Question: Describe this figure in one sentence.
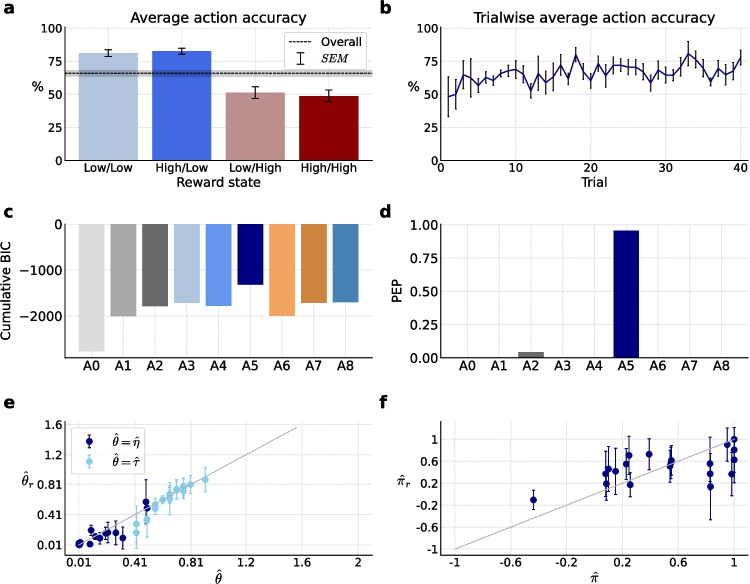
Answer: Post-hoc model validation analyses results. The panels depict post-hoc model validation analyses results of 50 data sets generated based on the most plausible behavioral model and the corresponding ML parameter estimates for each participant. The data analysis procedure was repeated 10 times. a Average action accuracy by reward state. The dashed line represents the overall average action accuracy across all reward states and the 10 data analysis repeats. The light gray area around this dashed line refers to the average SEM . The colored bars represent the reward state-specific average action accuracies. The error bars depict the SEM . b Trialwise average action accuracy across all reward states and the 10 data analysis repeats. Error bars refer to the SD across the 10 data analysis repeats. c Group-cumulative BIC values for all behavioral models in our model space. Behavioral models are differentiated by their bar colors. Higher BIC values refer to higher model plausibility (cf. Schwarz, 1978 ) d PEPs for all behavioral models in our model space. e Parameter recovery results for agent A5 ( \documentclass[12pt]{minimal} \usepackage{amsmath} \usepackage{wasysym} \usepackage{amsfonts} \usepackage{amssymb} \usepackage{amsbsy} \usepackage{mathrsfs} \usepackage{upgreek} \setlength{\oddsidemargin}{-69pt} \begin{document}$$n = 20$$\end{document} n = 20 ). ML estimates of the experimental data are displayed on the x-axis, where \documentclass[12pt]{minimal} \usepackage{amsmath} \usepackage{wasysym} \usepackage{amsfonts} \usepackage{amssymb} \usepackage{amsbsy} \usepackage{mathrsfs} \usepackage{upgreek} \setlength{\oddsidemargin}{-69pt} \begin{document}$$\hat{\theta }$$\end{document} θ ^ either refers to the estimated learning rate parameter values \documentclass[12pt]{minimal} \usepackage{amsmath} \usepackage{wasysym} \usepackage{amsfonts} \usepackage{amssymb} \usepackage{amsbsy} \usepackage{mathrsfs} \usepackage{upgreek} \setlength{\oddsidemargin}{-69pt} \begin{document}$$\